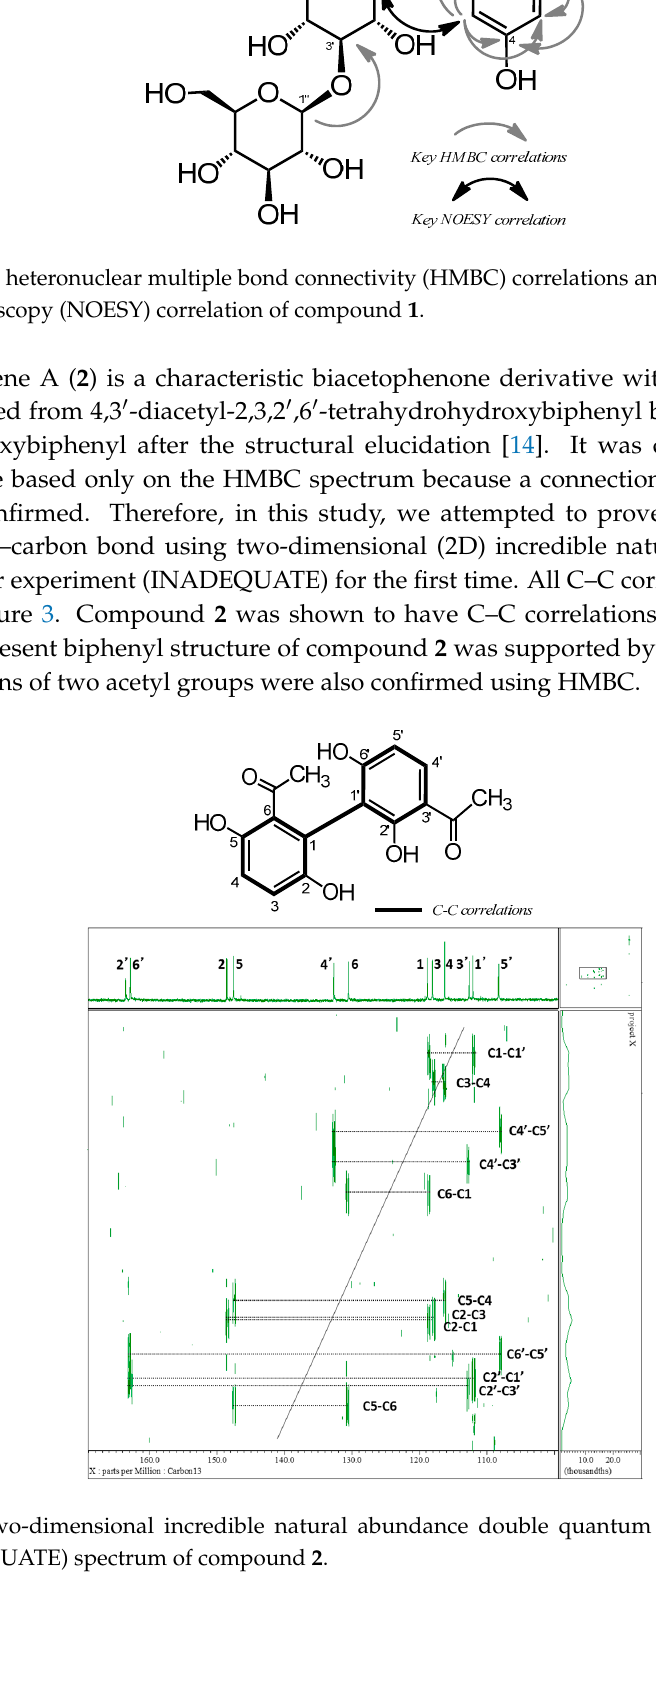
Figure 3. Two-dimensional incredible natural abundance double quantum transfer